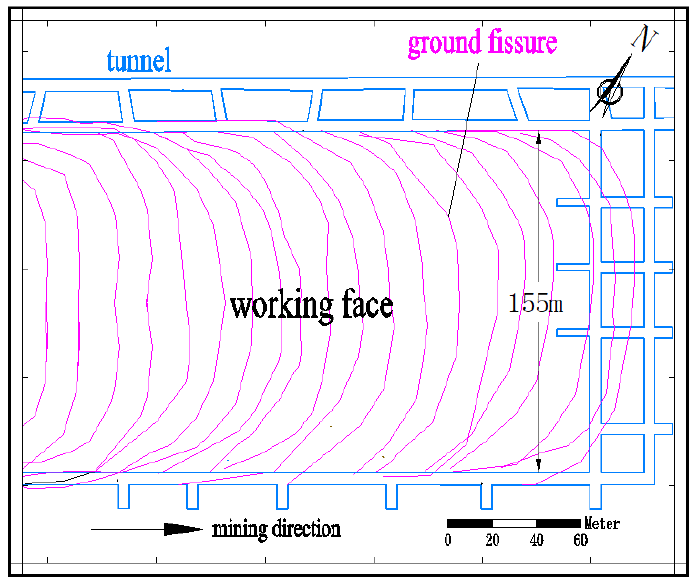
Figure 7. Schematic diagram of the ground fissure and corresponding working face sections during mining. (The pink line represents the ground fissure measured in the previous coal seam, and the blue line represents the face tunnel).